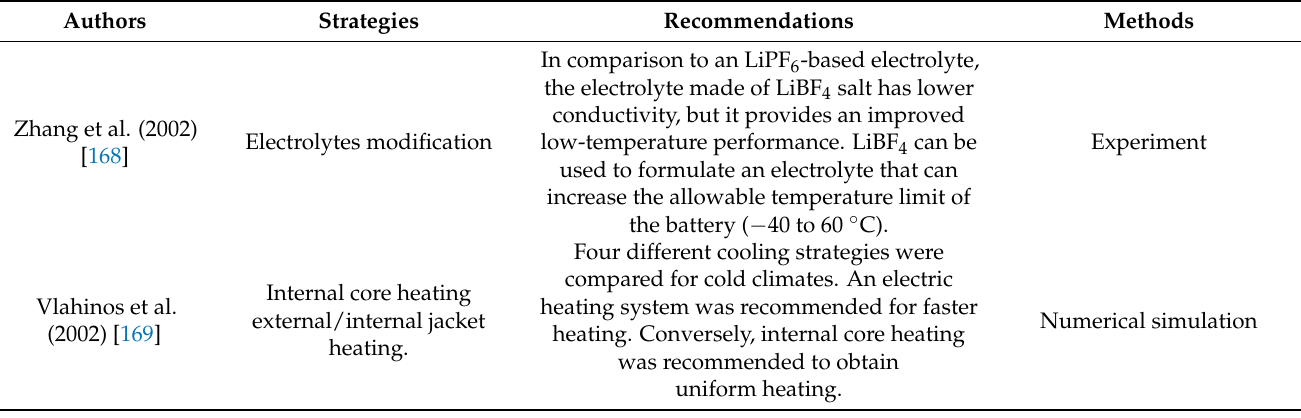
Table 6. Recent developments of in situ battery thermal management